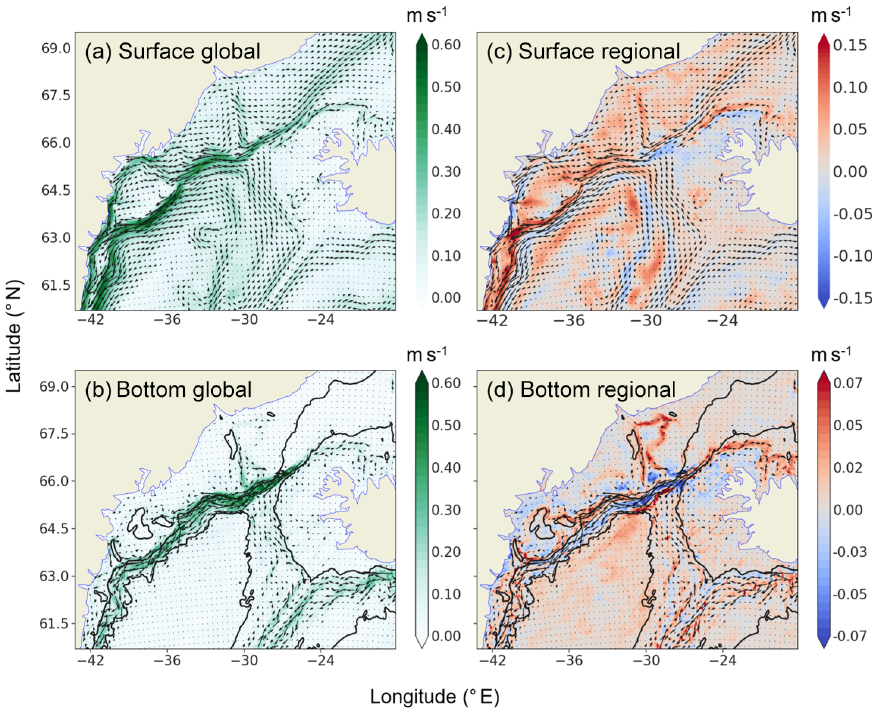
Figure 2. Surface (a) and bottom (b) mean currents (year 76) in the global ORCA12 simulation. Vectors and colours indicate current direction and speed (ms − 1 ). Surface (c) and bottom (d) mean currents (year 76) in the regional DSO12.L46 regional simulation. Vectors indicate the direction of the current. Colours indicate the current speed difference between the global and the regional simulation (ms − 1 ). Blue and red indicate that the current speed is greater or smaller in the global or regional simulation.